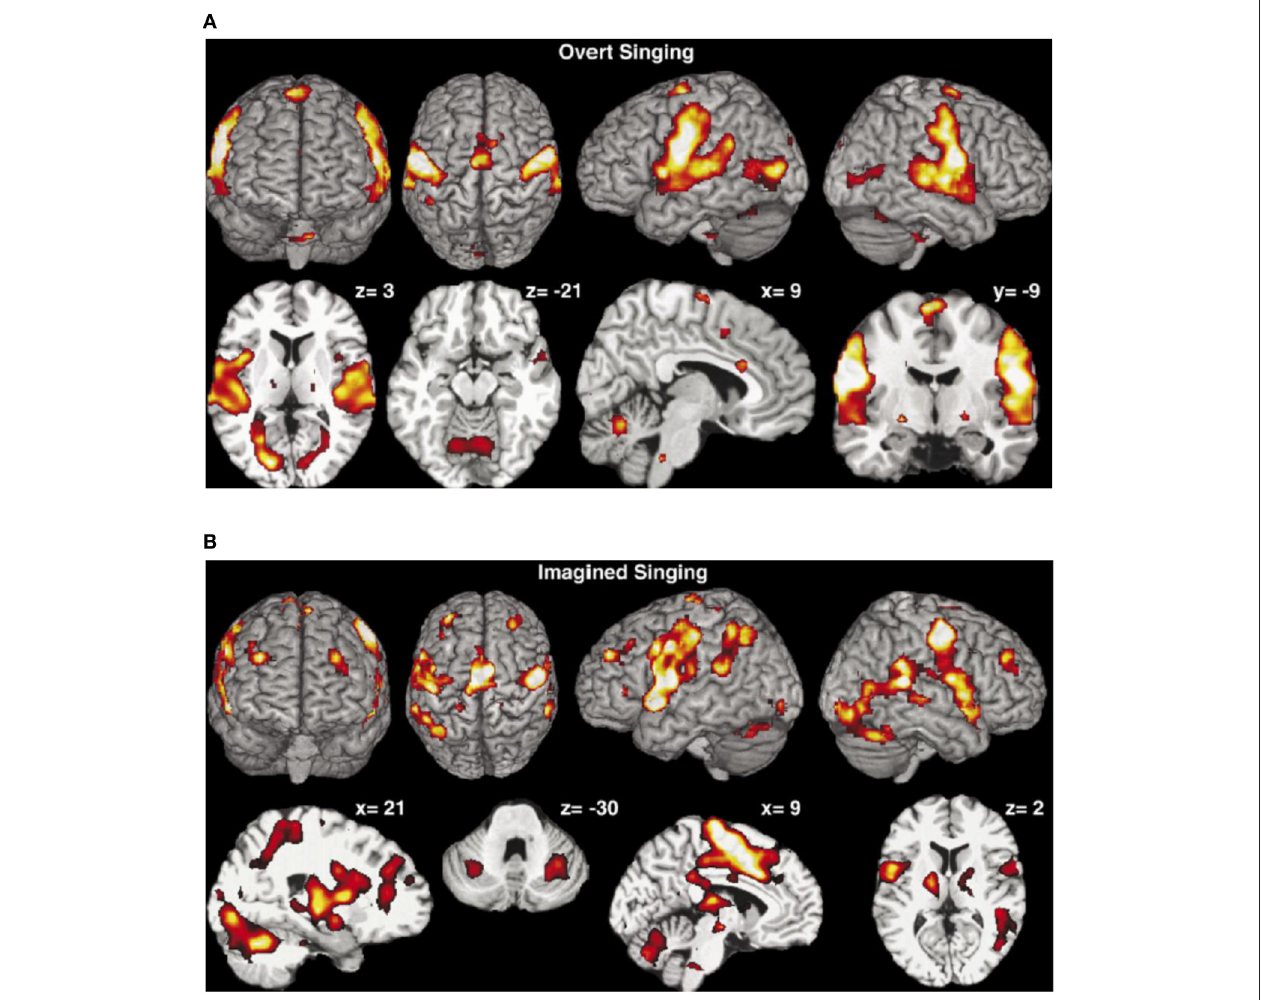
FIGURE 10 | (A) Overt singing. The activation maps show activations of the bilateral sensorimotor cortex and the cerebellum, the bilateral auditory cortex, Broca’s and Wernicke’s areas, medulla, thalamus, and ventral striatum but also ACC and insula were activated. Coordinates of cuts are given above each slice (Kleber et al., 2007). Reprinted with permission from Kleber et al. (2007) © 2007 Elsevier. (B) Mental rehearsal of singing (imaginary singing). Activation of typical imagery regions such as sensorimotor areas (SMA), premotor cortex areas, thalamus, basal ganglia, and cerebellum. Areas processing emotions showed intense activation (ACC and insula, hippocampus, amygdala, and ventrolateral prefrontal cortex). Coordinates of cuts are given above each slice (Kleber et al., 2007). Reprinted with permission from Kleber et al. (2007) © 2007 Elsevier.